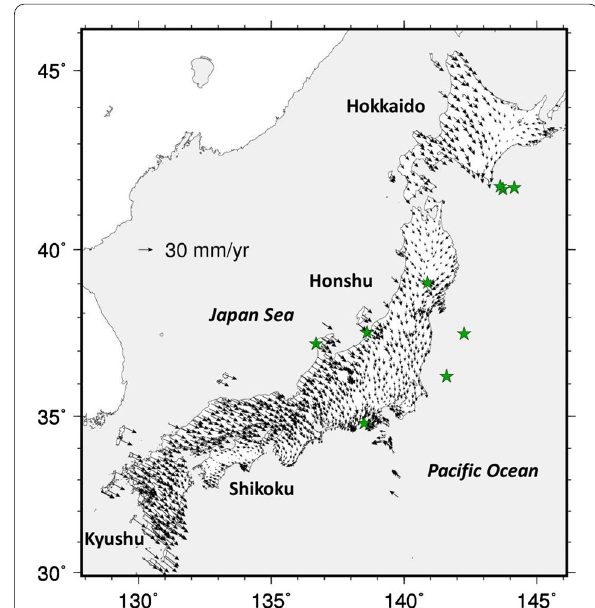
Fig. 1 Horizontal velocity observed at permanent GNSS stations with respect to the ITRF 2014 for January 2006–December 2009. Green stars represent the epicenters of earthquakes whose coordinate offsets are removed from GNSS